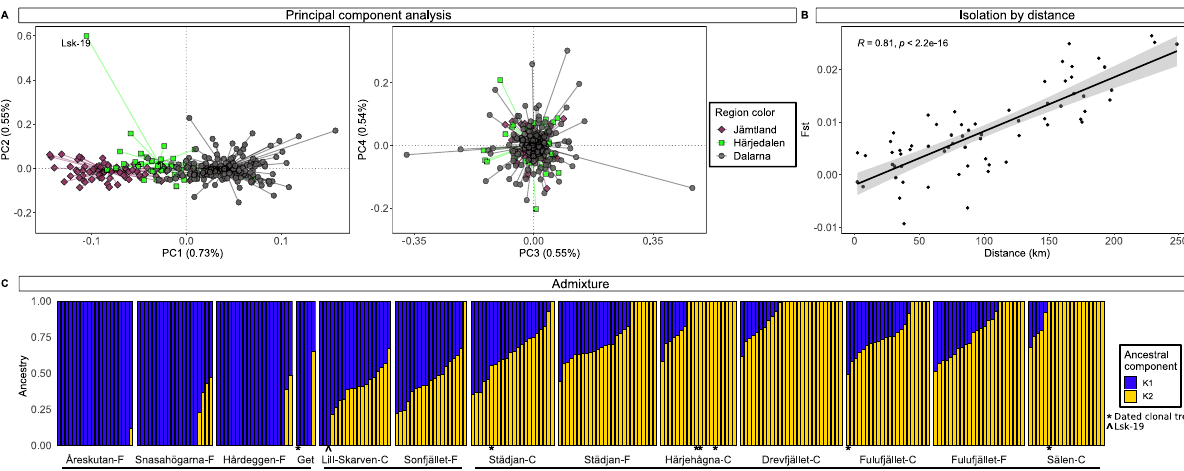
Fig. 3 Overview of the results obtained using nuclear MIG-seq sequence data and 14,969 SNPs on contemporary spruce populations from the central Scandes. A PCA analysis results (1st to 4th axes); PC1 shows a grouping based on geographical location with one outlier (Lsk-19) on the second axes. PCA axes 3 and 4 do not separate the populations further. In the PCA each point represents an individual coloured according to the sampling area. B Fst-values between populations plotted against geographical distances and showing a strong correlation (each dot in the plot represents a pairwise comparison between the populations given in Supplementary Table 2). Pearson correlation (two-sided) and Fitting Generalized Linear Model (GLM) was used to produce con fi dence interval. C admixture plots for K = 2 showing a declining proportion of the ancestral component dominant in the north (K1 = blue) in the more southern populations (K2 = yellow). Populations are ordered along latitude from the most northern population Åreskutan to the most southern population Sälen. Clonal trees are indicated with an asterisk and sample Lsk-19 with the ^ symbol. Source data are provided as a Source Data fi